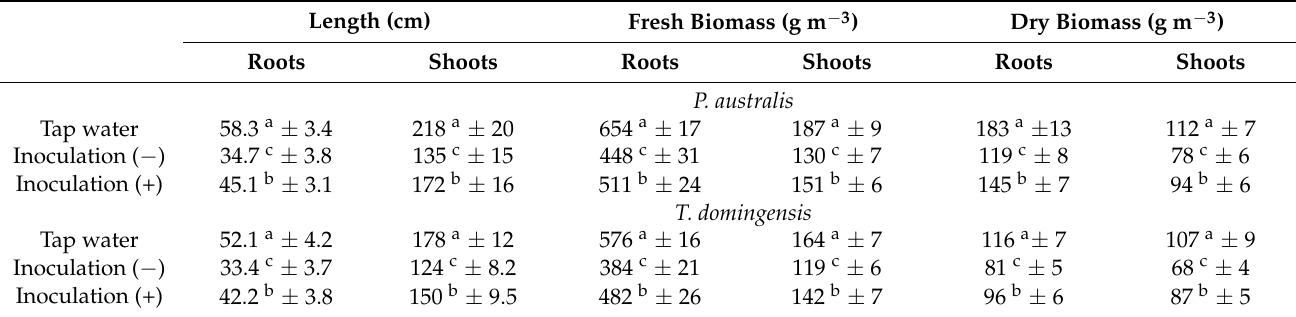
Table 1. Effect of bacterial inoculation on mean length of roots and shoots of Phragmites australis and Typha domingensis , and plant biomass per m 3 of water. Length (cm) Fresh Biomass (g m − 3 ) Dry Biomass (g m − 3 ) Roots Shoots Roots Shoots Roots Shoots P.